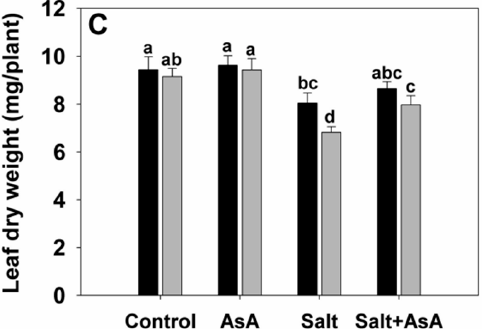
Figure 4. Exogenous AsA mitigated the salt hypersensitivity of ss3 mutants. Ten-day-old seedlings were transferred for four days to a nutrient solution containing 0 mM or 100 mM NaCl supplied with or without 1 mM AsA. The chlorophyll (Chl) content ( A ), protein content ( B ), and leaf dry weight ( C ) were assayed. The values are means ± SE of five replicates. Significant differences at p < 0.05 are indicated with different letters. FW—fresh weight.